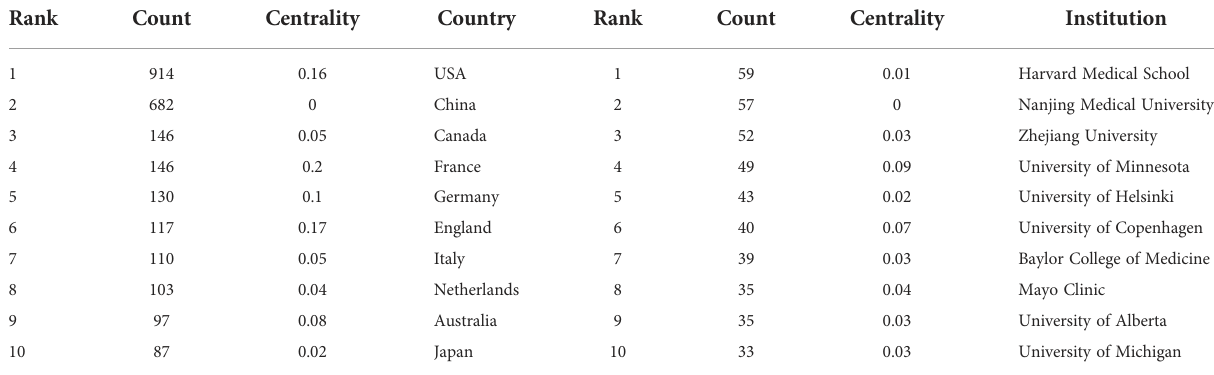
TABLE 1 The most productive countries and institutions in FMT research.